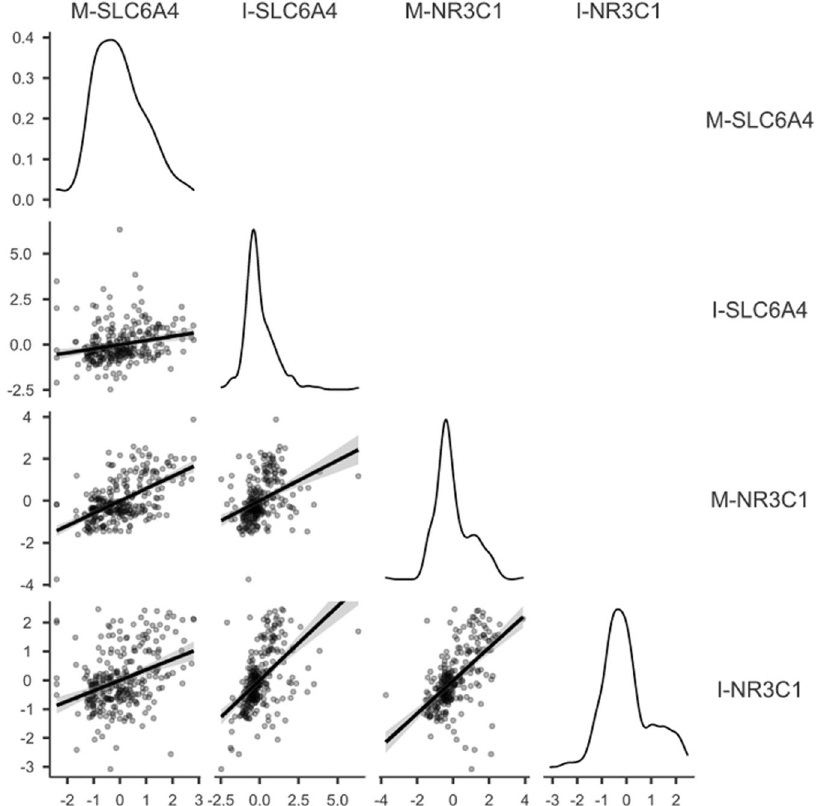
Fig. 1 Correlation matrix for maternal and infant SLC6A4 and NR3C1 principal component scores. X - and Y axes report methylation percentage. Density plots on diagonal. Note. *** P <